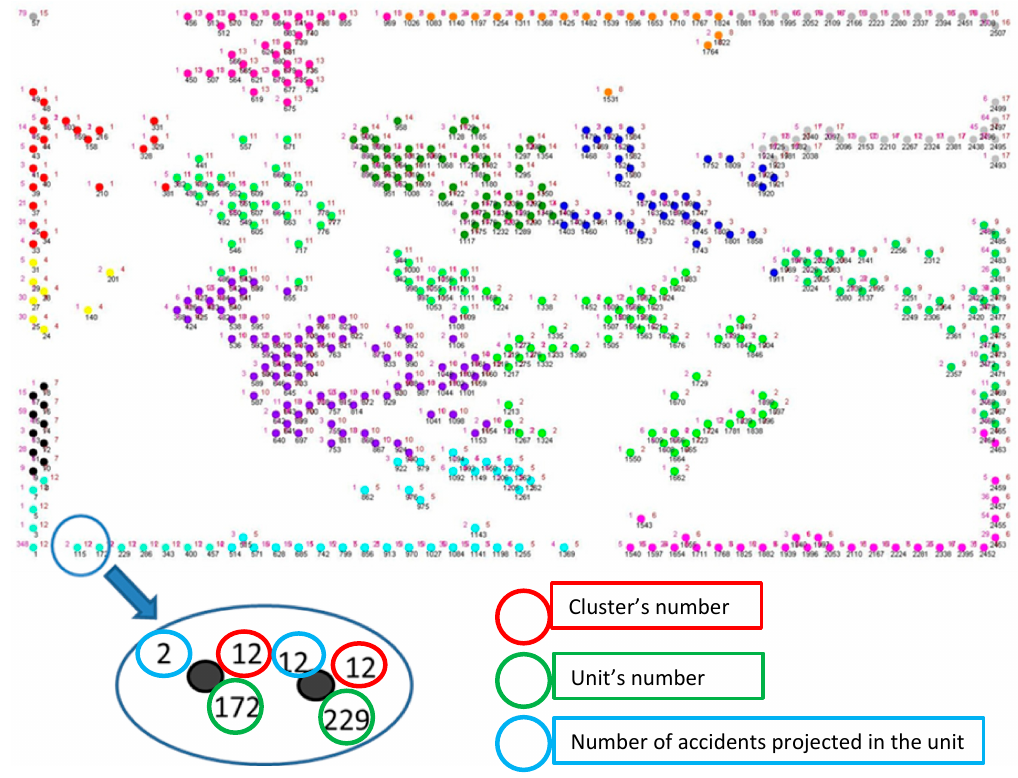
Figure 2. Partition output.